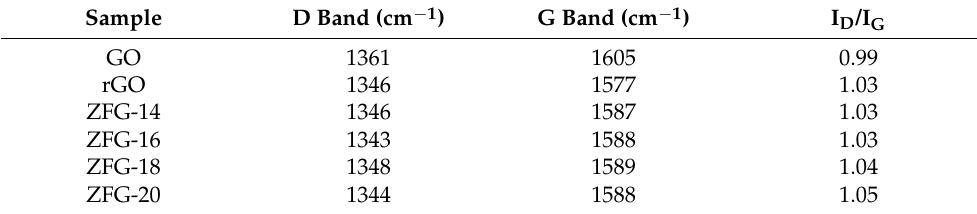
Table 1. D and G band location and I D /I G value of GO, rGO, and